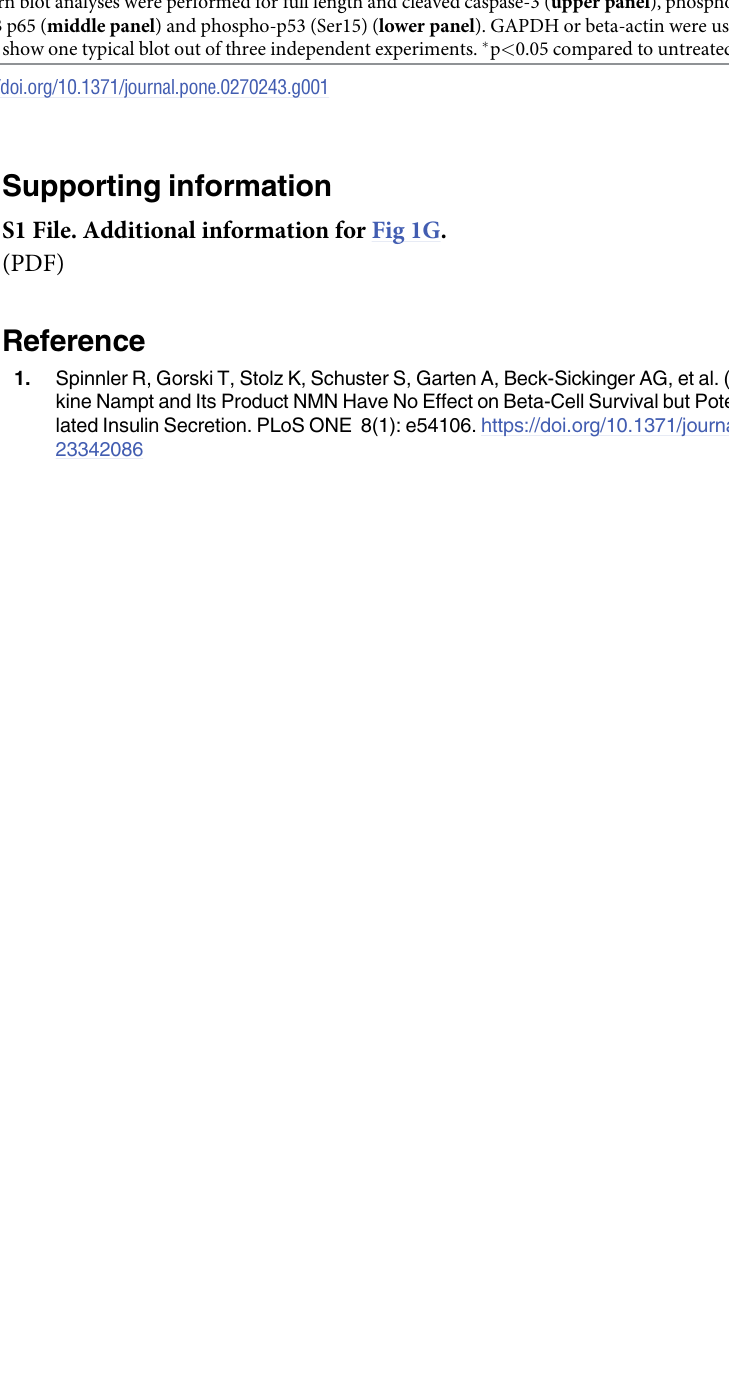
S1 File. Additional information for Fig